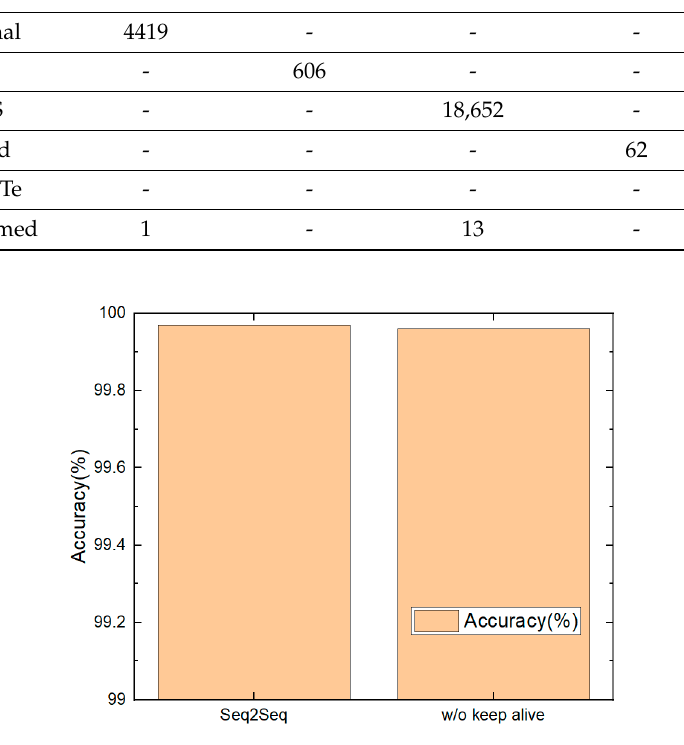
Figure 17. Accuracy when keep alive is not used. Table 8. Confusion matrix when keep alive is not used.